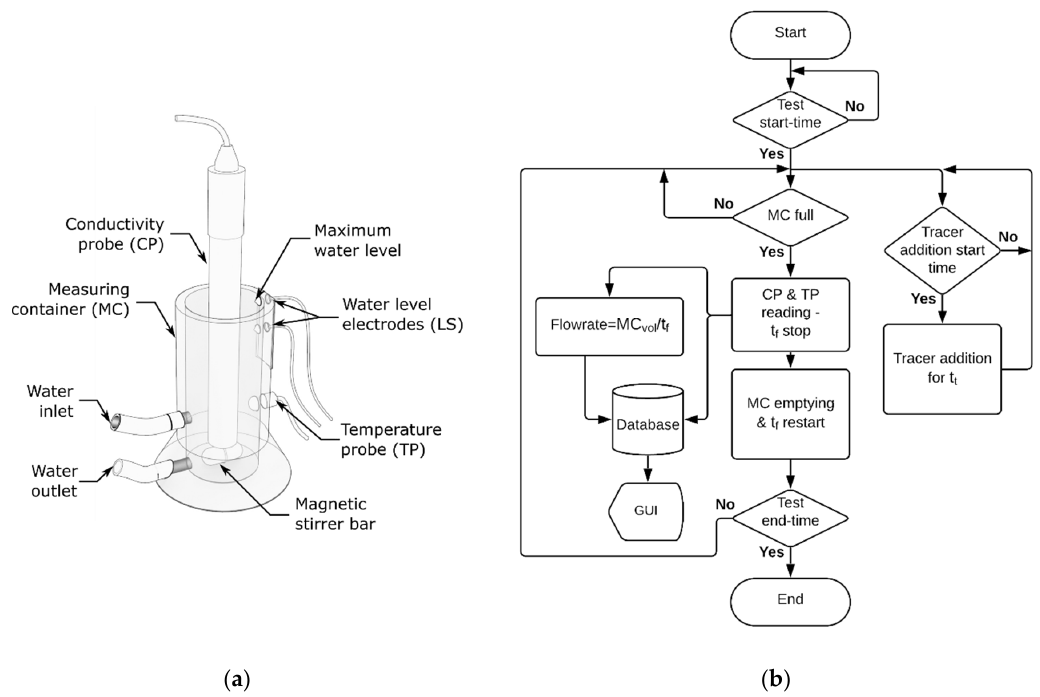
Figure 2. ( a ) Parts of the measuring container, ( b ) Operation flowchart of the automated RTD measurement system. No- menclature: MC—measuring container; CO—conductivity probe; TP—temperature probe; t f —measuring container filling time; t t —tracer addition time; MC vol —measuring container volume.